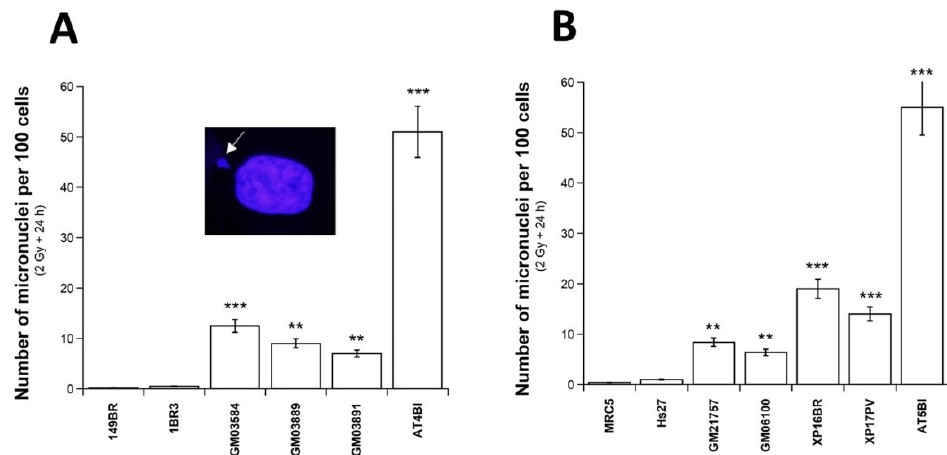
Figure 2. Micronuclei in USH1 fibroblasts: Number of micronuclei per 100 cells assessed 24 h after 2 Gy X-rays in the radioresistant controls 1BR3 and 149BR, the hyper-radiosensitive ATM -mutated AT4BI, and the three USH1 (GM03854, GM03889, and GM03891) fibroblast cell lines ( A ), and in the radioresistant controls MRC5 and Hs27, the hyper-radiosensitive ATM -mutated AT5BI, the HD (GM21757), the TSC (GM06100), and two XPD (XP16BR and XP17PV) fibroblast cell lines ( B ). Each plot represents the mean ± SEM of three replicates. The insert shows a representative example of a micronucleus observed via DAPI counterstaining. Asterisks represent the statistically significant differences from radioresistant controls, expressed as p -values (2 and 3 asterisks correspond to p < 0.01 and p < 0.001, respectively).